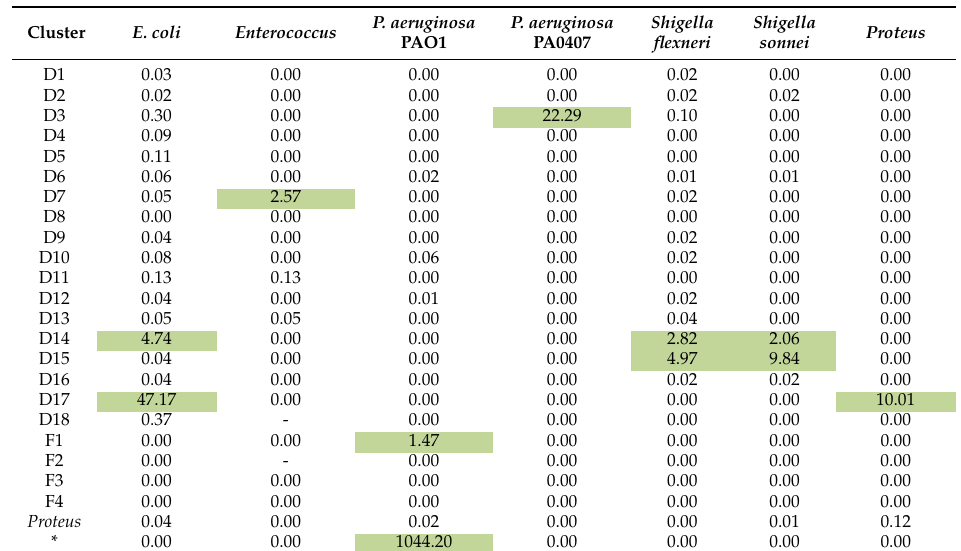
Table 3. Depth of coverage ratio of host-amplified samples to the Intesti sample. Combinations with a ratio greater than 1.0 are indicated by green background coloring. Those are thought to be the infecting clusters, as they are more abundant in the host-amplified sample than in the original one. In the last line is shown a phage cluster, which has not even been considered in the initial contig grouping of the Intesti sample because of its small size of only 1346bp and low depth of coverage of only 2 ˆ . It has, however, been greatly amplified on P. aeruginosa strain PAO1.Results regarding the amplification on Salmonella were inconclusive and therefore removed (see